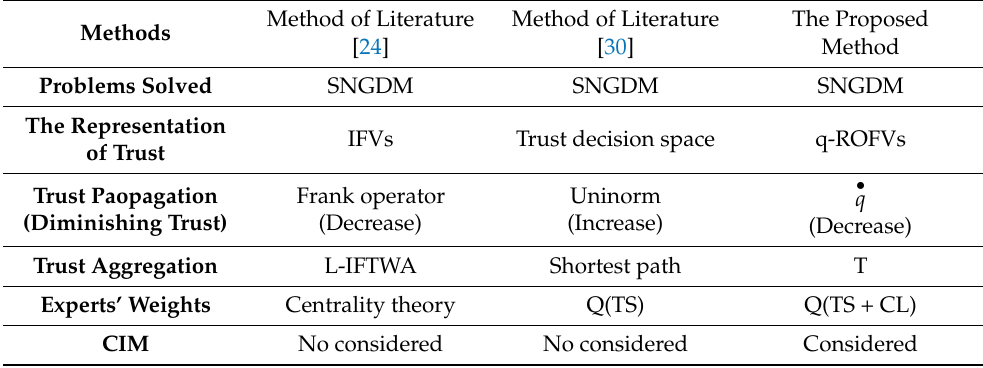
Table 3. Comparative